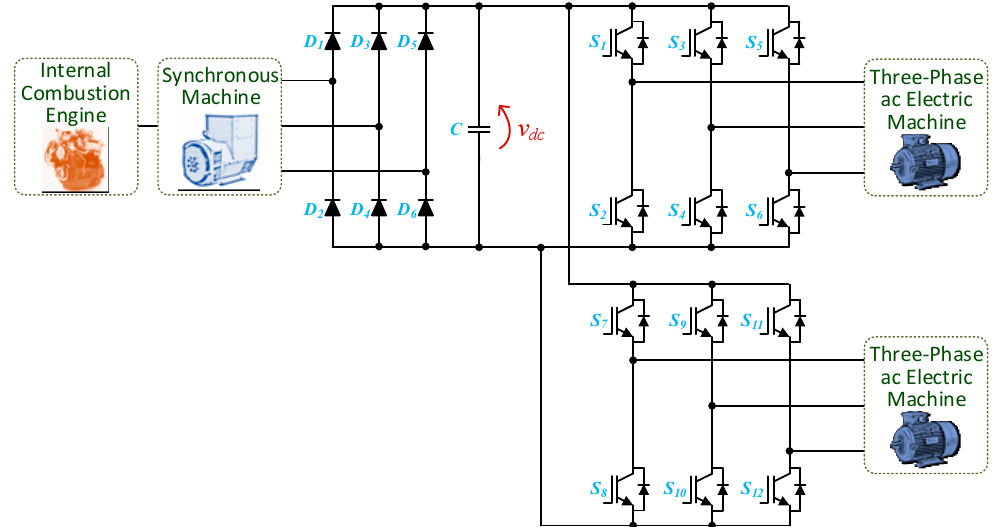
Figure 36. Traction system for an electric truck based on two three-phase ac electric machines.